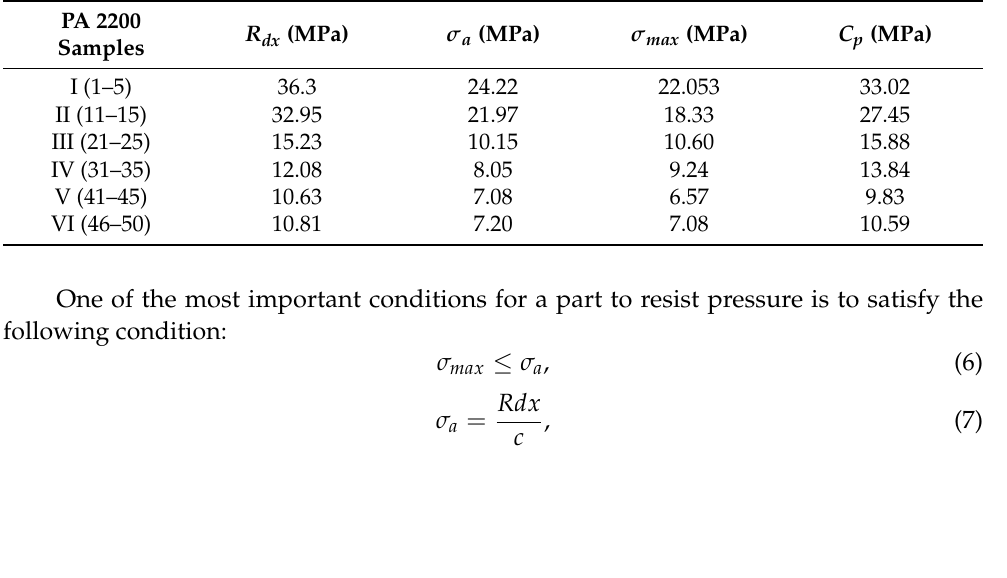
Table 4. Mechanical characteristics determined by FEA for the hip implant prostheses.